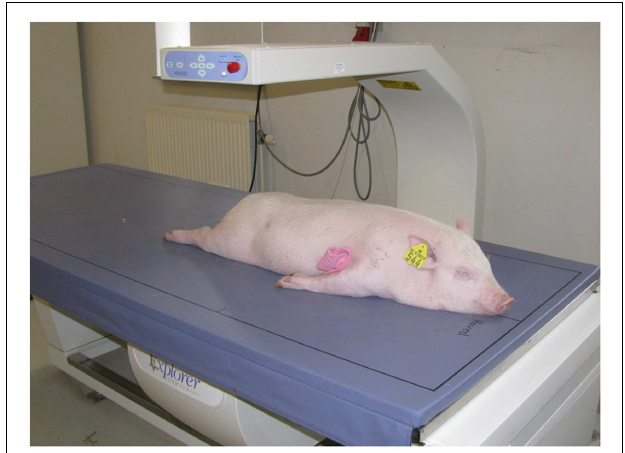
FIGURE 2 |A dual-energy x-ray absorptiometry (DXA) scan of one of the pigs at approximately 2.5months old.